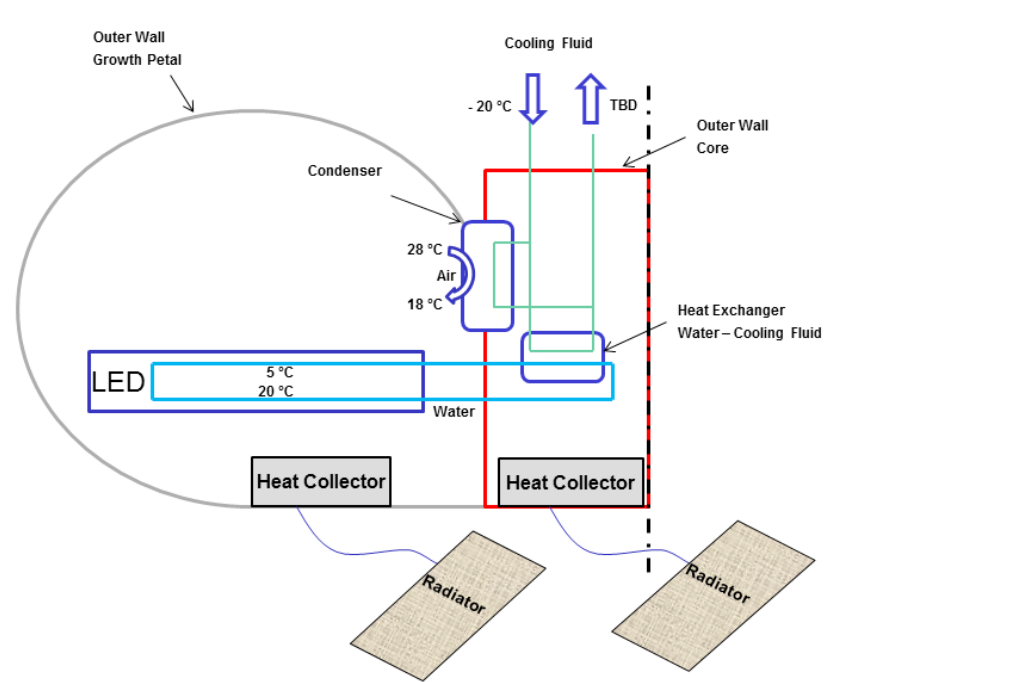
Figure 16: Schematic representation of the TCS (in the picture, the condenser works as an air heat